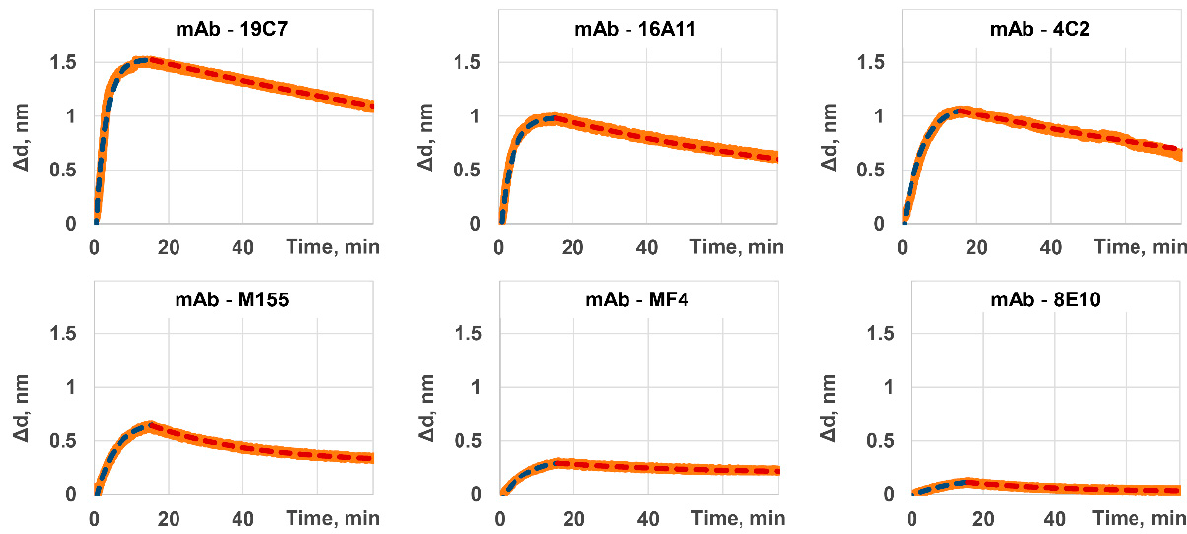
Figure 3. Sensorgrams recorded by the mSCI-biosensor show the stages of association and dissociation of the cTnI antigen with various mAb clones.